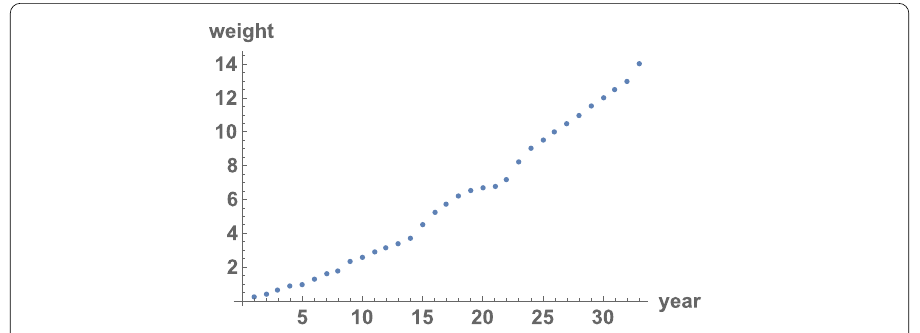
Figure 1 Data on fish weights. In the horizontal axis, we represent the years, from 1 to 33. In the vertical axis, we represent the weights in